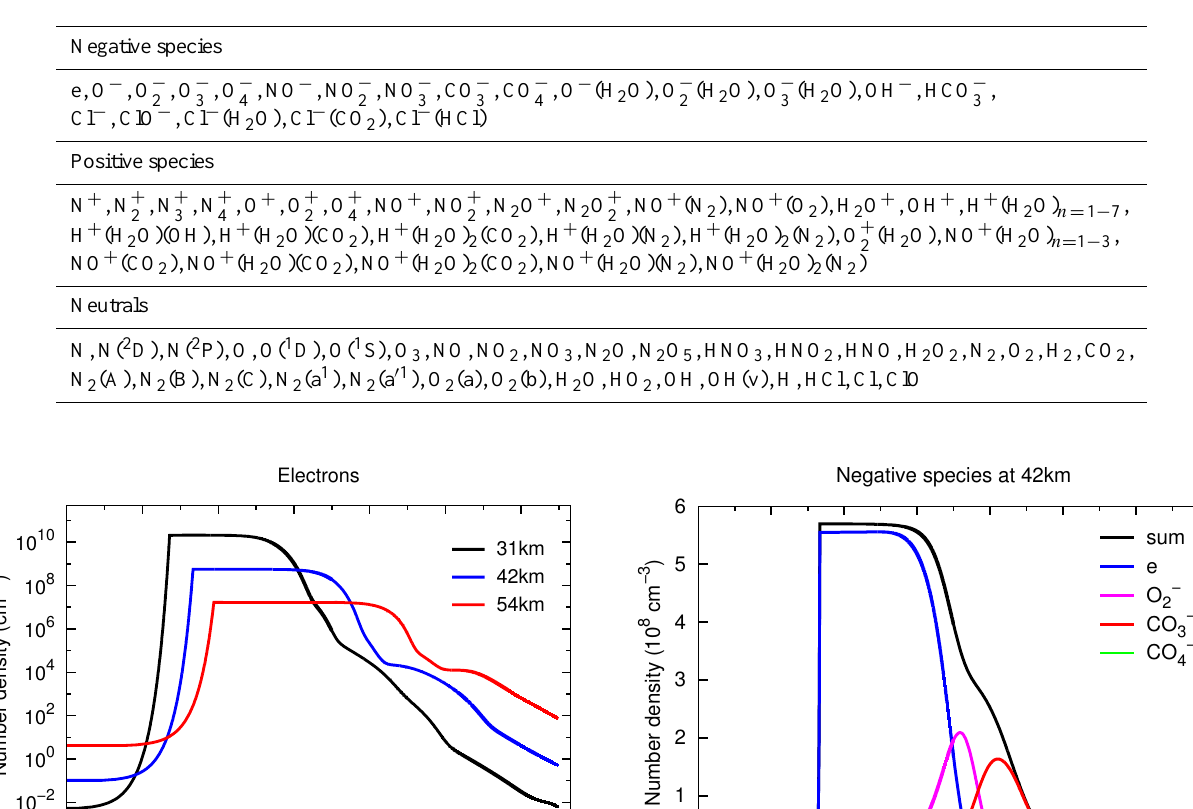
Table 1. Modelled species.